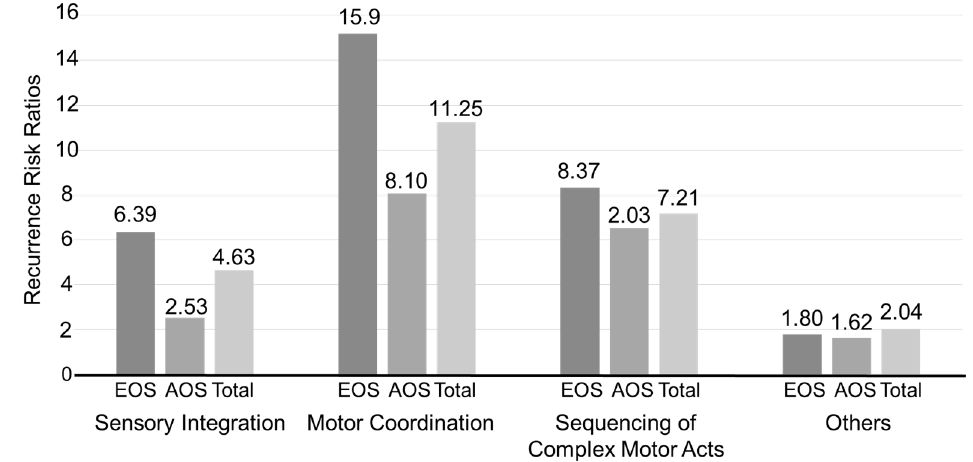
Figure 3. The proportion of subjects with NSS scores above cut-off thresholds and corresponding recurrence risk ratios. For Motor Coordination, the NSS cut-off point is ≥ 1; for Sensory Integration, Motor Coordination and Sequencing of Complex Motor Acts, the NSS cut-off point is ≥ 2 due to the stability of the model.